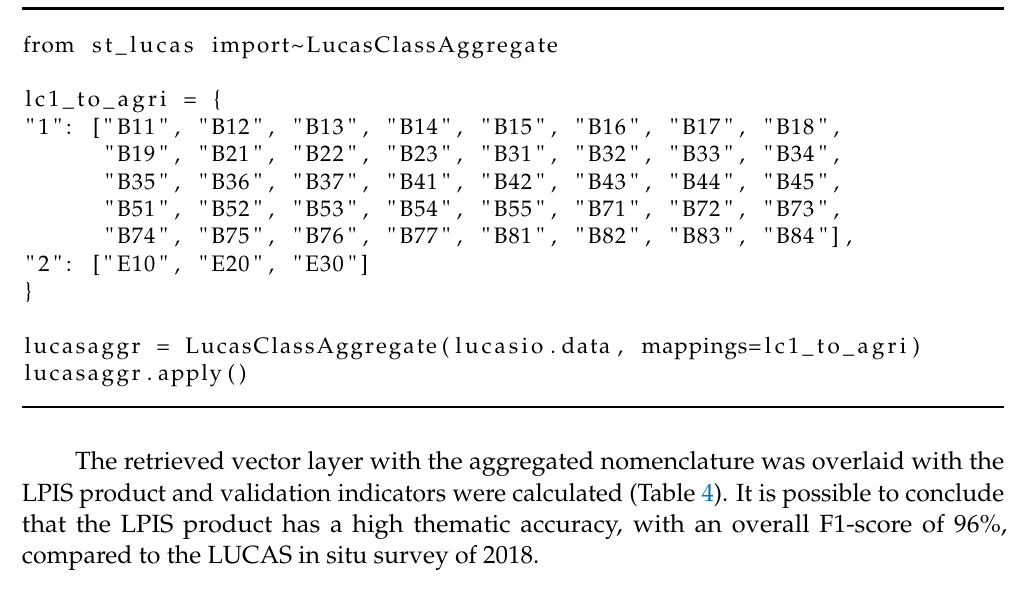
Table 4. LPIS validation